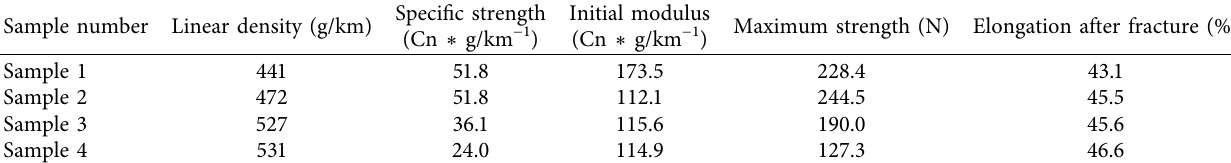
Figure 2: Simplified model of force analysis in badminton batting Table 1: Mechanical properties of four badminton rackets.